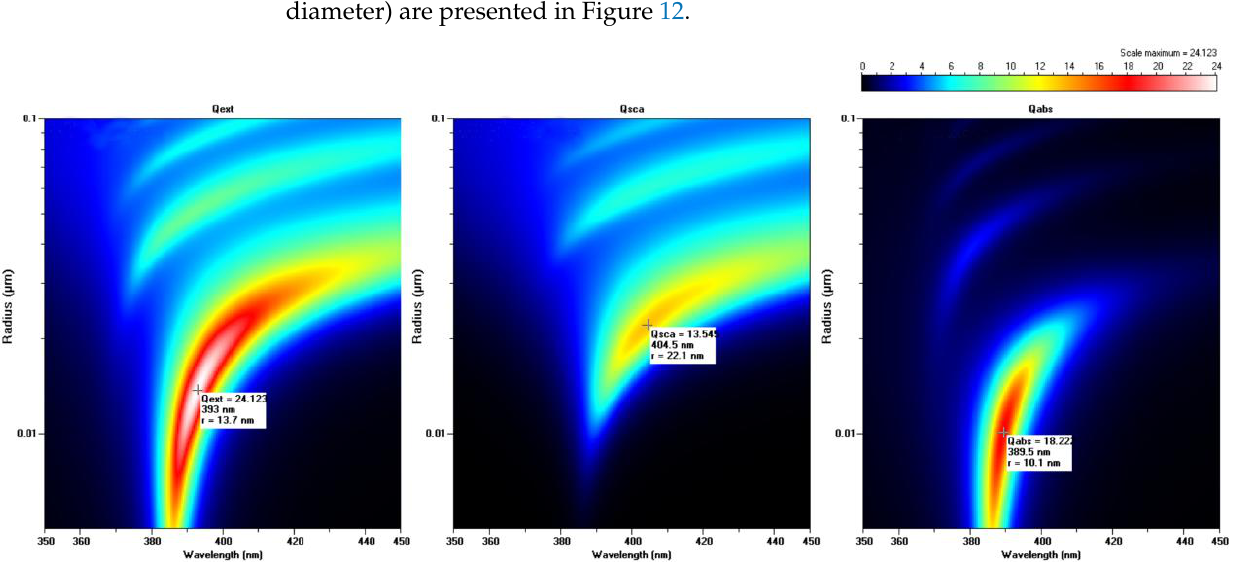
Figure 12. Qext, Qsca, and Qabs as a function of particle radius r and wavelength λ . Figure 13. Qext, Qsca, and Qabs as a function of particle radius r and wavelength λ. The color indicates the magnitude of Qext, and, implicitly, the maximum values The color indicates the magnitude of Qext, and, implicitly, the maximum values depending on the nanoparticle radius. Q ext is the sum of Q sca and Q abs depending on the nanoparticle radius. Q ext is the sum of Q sca and Q abs [75].